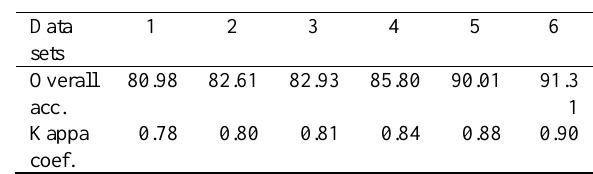
Table 4. RF classification results for Landsat 8 OLI/TIRS and additional bands